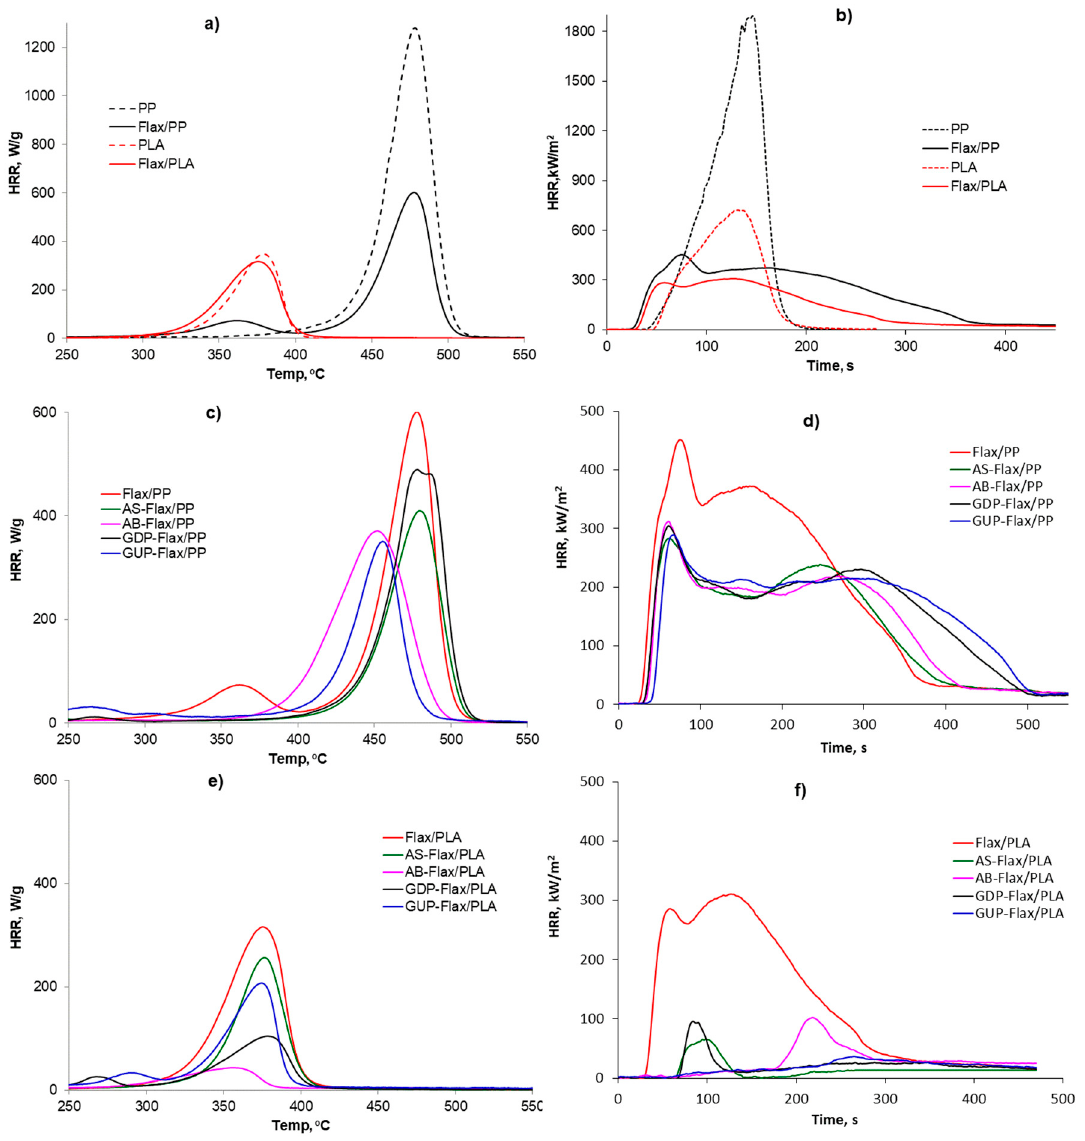
Figure1. Heatreleaserate(HRR)versus( a , c , e )tempinpyrolysisflowcalorimetry(PCFC)and( b , d , f )time Figure 1. Heat release rate (HRR) versus ( a , c , e ) temp in pyrolysis flow calorimetry (PCFC) and ( b , d , f ) in cone calorimetry at 35 kW / m 2 for flax / PP and flax PLA composites, and PP and PLA time in cone calorimetry at 35 kW/m 2 for flax/PP and flax PLA composites, and PP and PLA plaques. Other principal parameters are the temperature at the maximum heat release rate ( T max ) and the total heat released; all of these parameters for all the samples are presented in Table 2. Table 2. PCFC results of unmodified and fire retarded Flax, PP, PLA, Flax/PP, and Flax/PLA fibres.